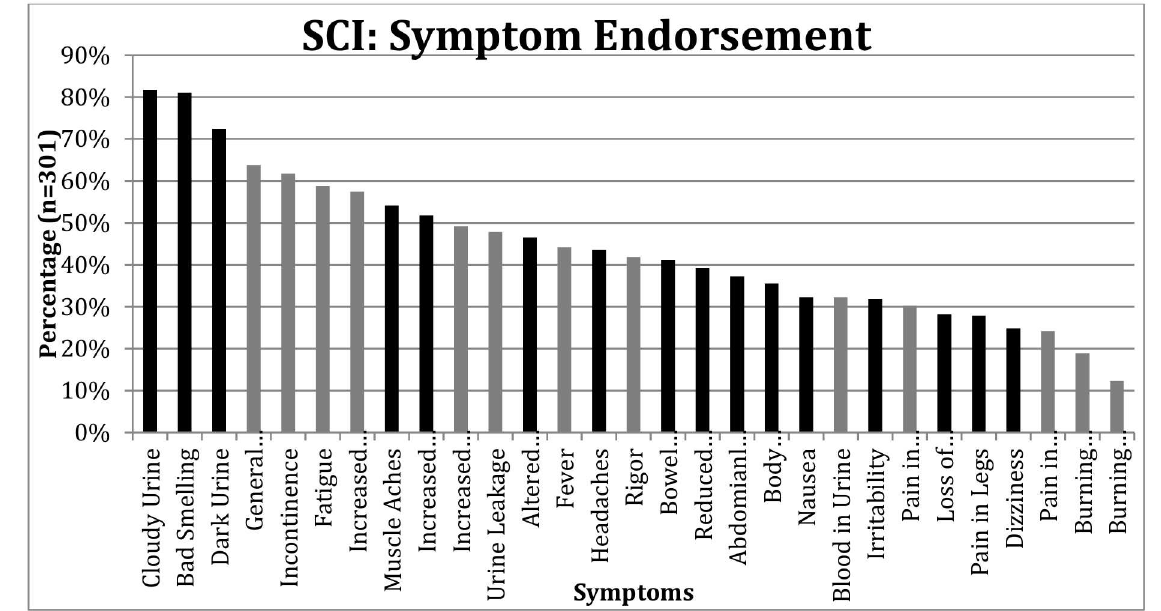
Fig 3. Endorsement rates (percent of 301 respondents) for signs and